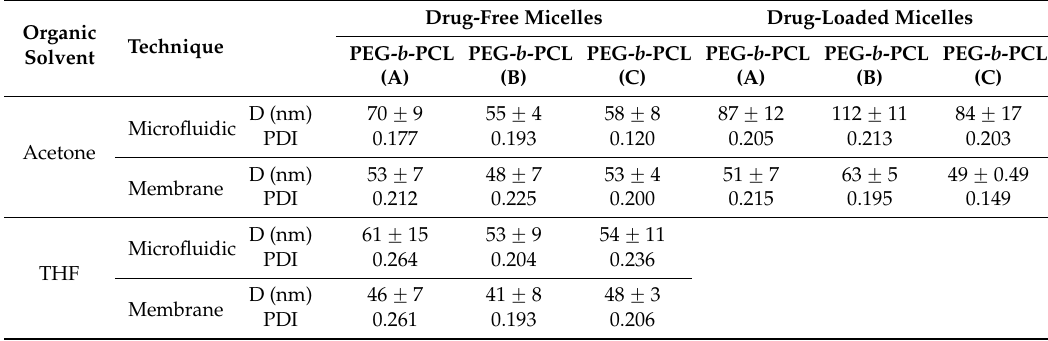
Table 2. The Diameter and Polydispersity index (PDI) of micelles formed using different copolymers, fabrication techniques and organic solvents. The copolymer concentration in the organic phase used for preparation of drug-free micelles was 1 mg ¨ mL ´ 1 . The organic phase used for preparation